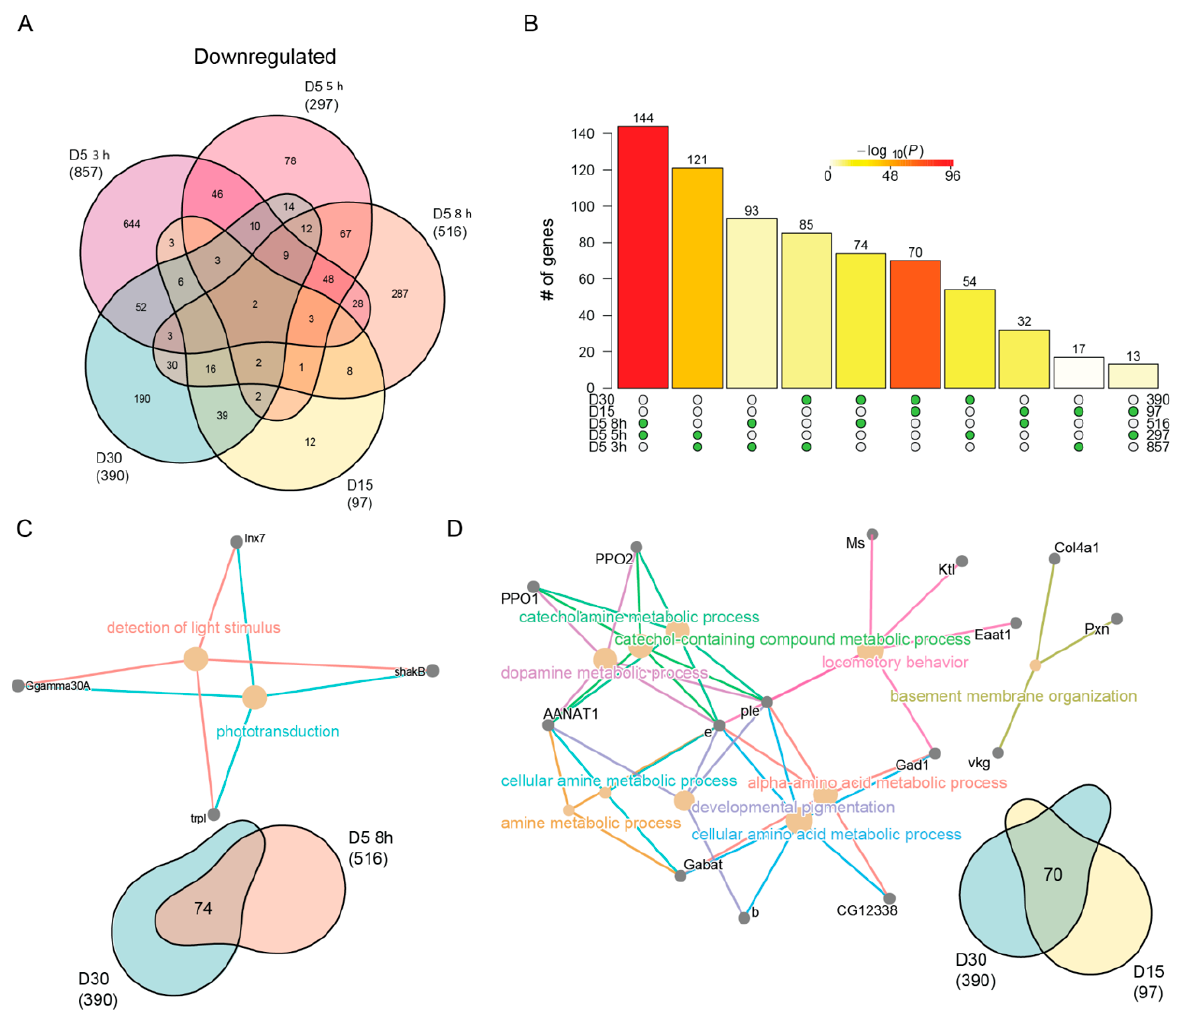
Figure 5. Neuronal specific genes are downregulated with age and blue light stress. ( A ) Venn diagram of the differentially downregulated genes in aged or blue light exposed flies relative to D5. ( B ) Statistical analysis for all pairwise comparisons of significantly downregulated genes in aging or blue light exposed conditions. Bar height represents the number of genes in each pairwise overlap (green dots). Bars are colored by p -values from fisher’s exact test, with the null hypothesis being an overlap no greater than that expected by chance. Cnetplots representing the enriched GO terms and corresponding genes for the intersection between ( C ) 8 h and D30 or ( D ) D15 and